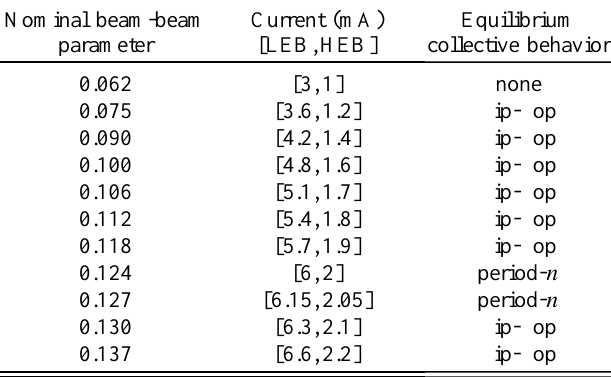
TABLE III. Equilibrium configuration after 10 000 turns (10 damping times). Energies are 3 and 9 GeV, so that en- ergy transparency is exactly